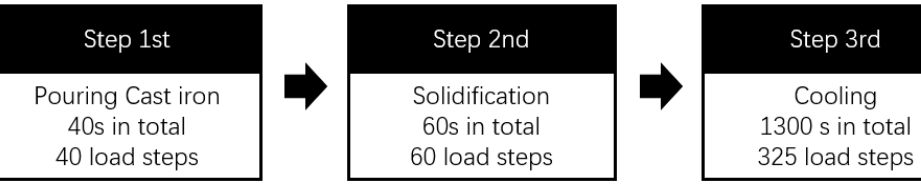
Figure 9. The flow chart of the solution.